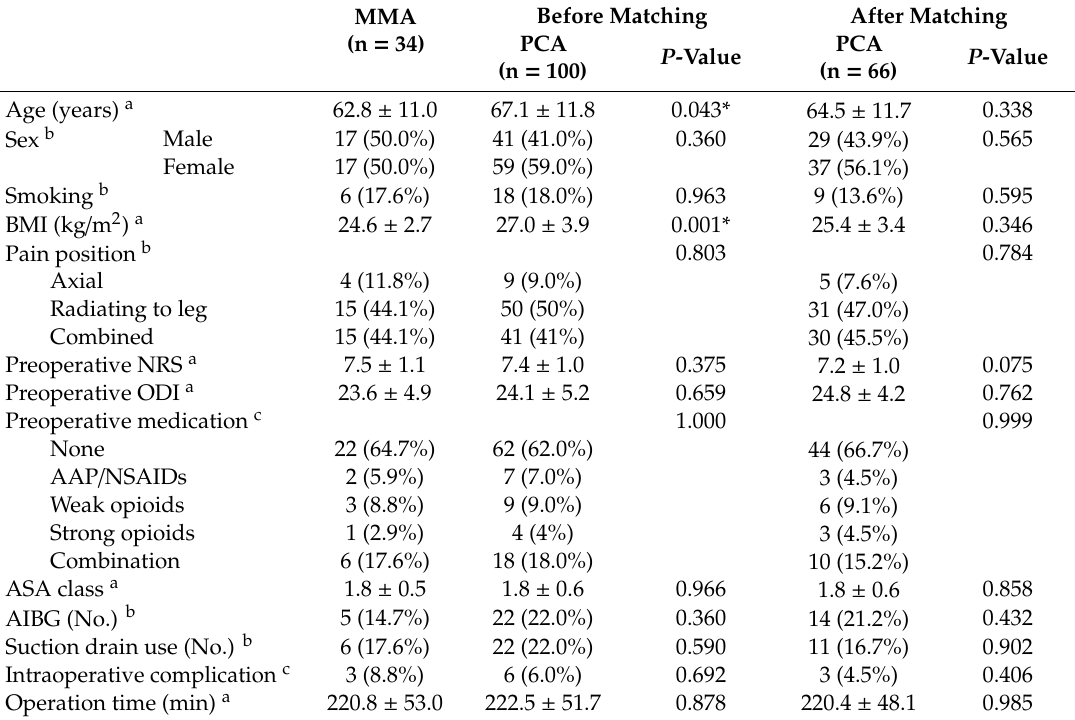
Table 2. Baseline data and clinical